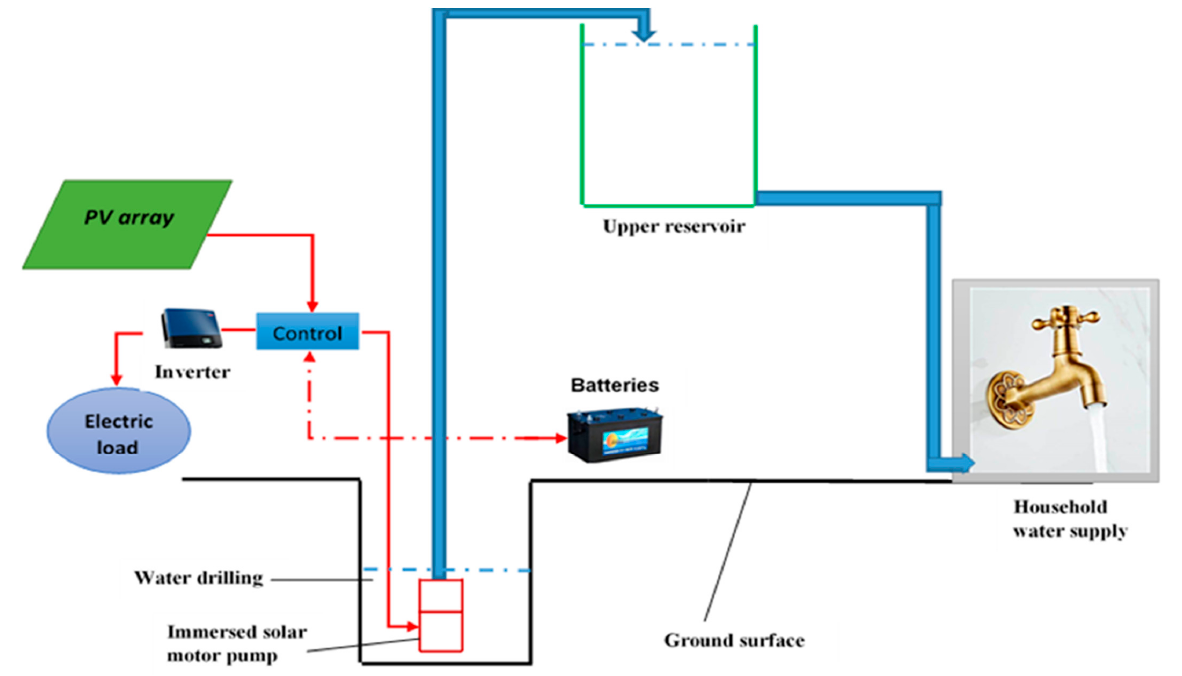
Figure 2. PV-system-based battery energy storage for electricity and water supply.